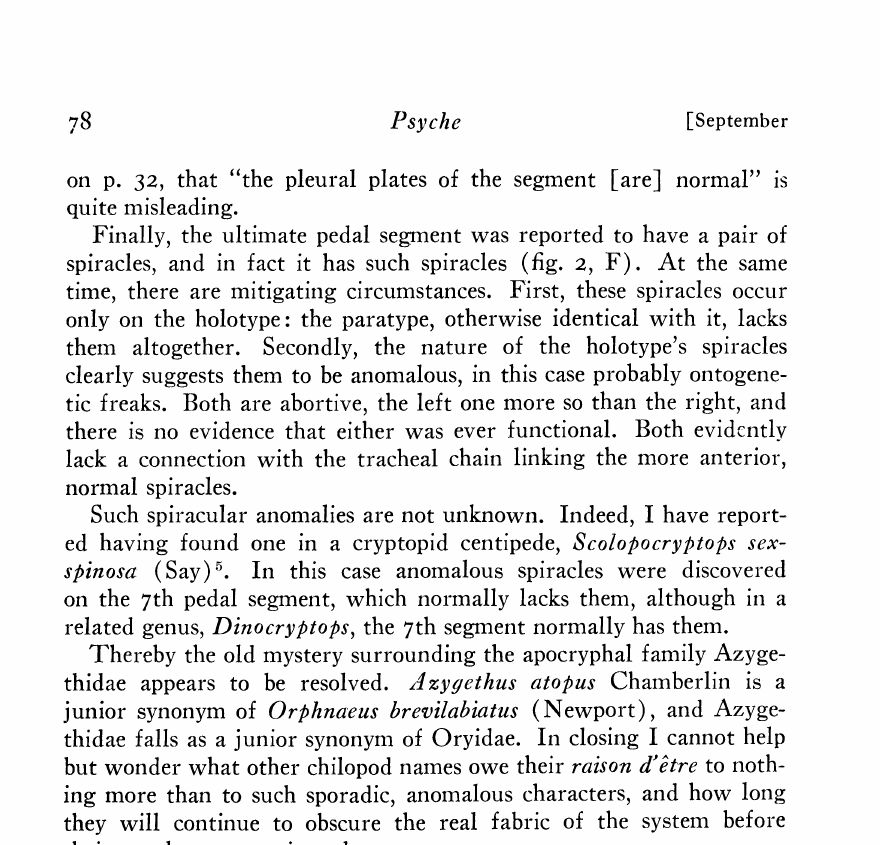
Figure 1. Paratype. First maxillae: left two-thirds, with adjacent second maxillae, the setae deleted. A=lappet of coxosternum. B=lappet of telopodite. C=telopodite. D--right medial lobe. E=coxosternum. F--hid- den continuation of coxosternum concealed beneath anterior edge of second maxillary coxosternum. Figure 2. Holotype. Posterior-most body segments: right side tilted slightly downward, setae deleted. A--tergum covering the postpedal seg- ments. B--tergite of ultimate pedal segment. C--Pretergite of ultimate pedal segment. D--Tergite of penultimate pedal segment. E--right ultimate leg. F--Spiracle and plate-like bulge of ultimate pedal segment. G--Coxo- pleuron. H--Parapretergite. I--Stigmopleurite of penultimate pedal seg- ment. J=Paratergite of penultimate pedal